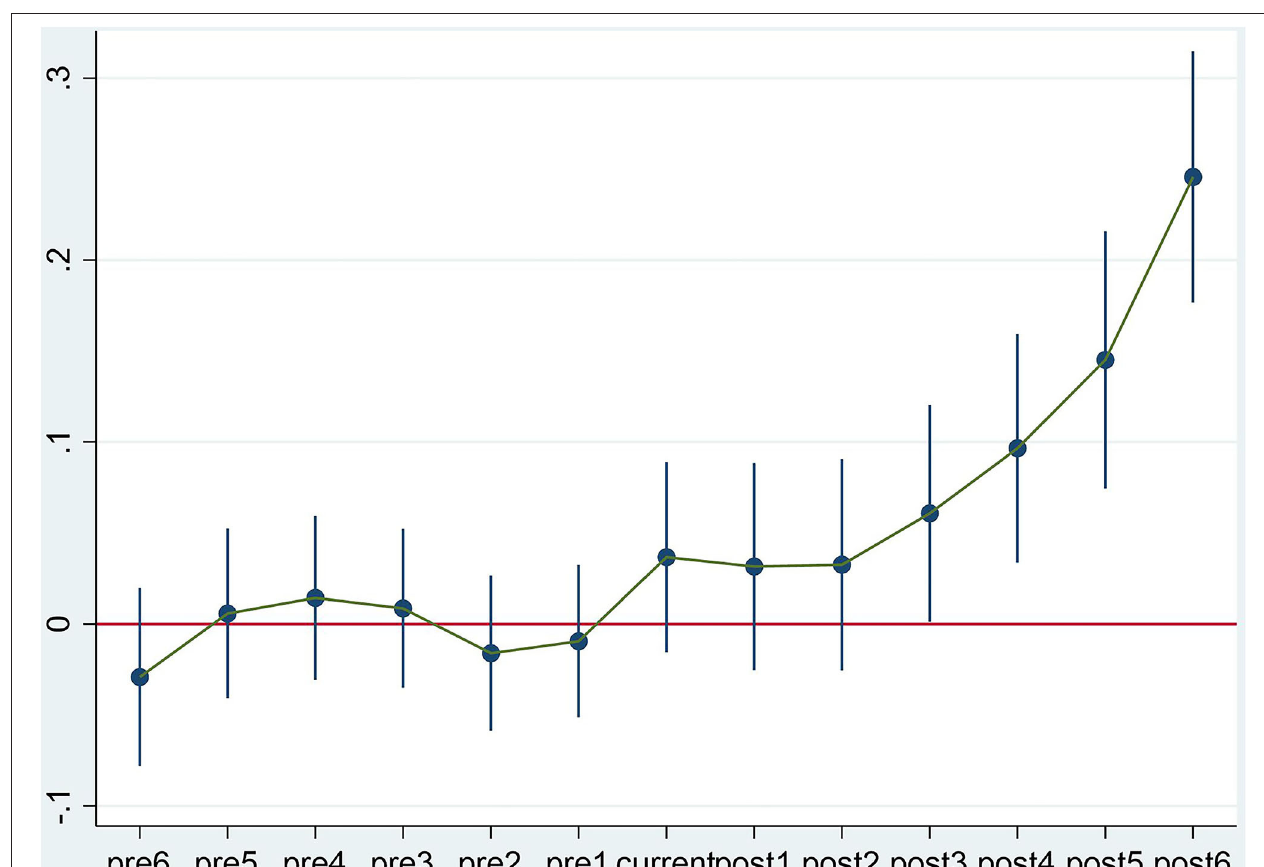
FIGURE 1 | Parallel trend and dynamic change of doctor resource